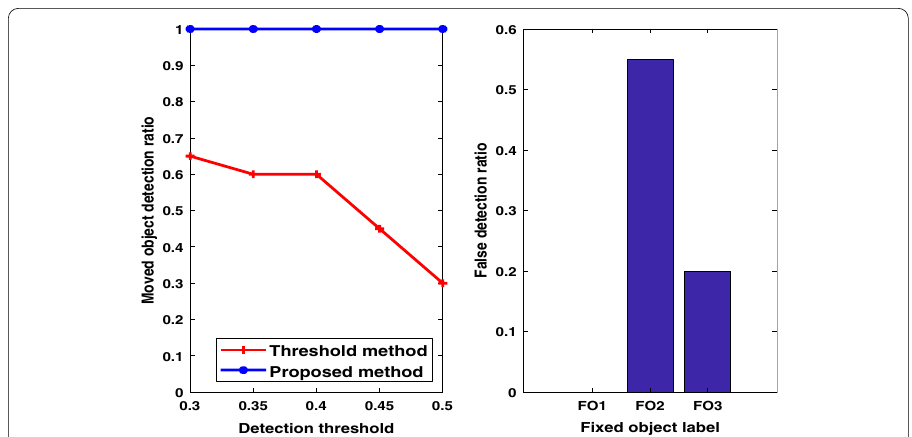
Fig. 12 The detection ratio comparison between our proposed and the threshold method, in addition a false ratio is also shown in this figure when the simulation is running in the real data